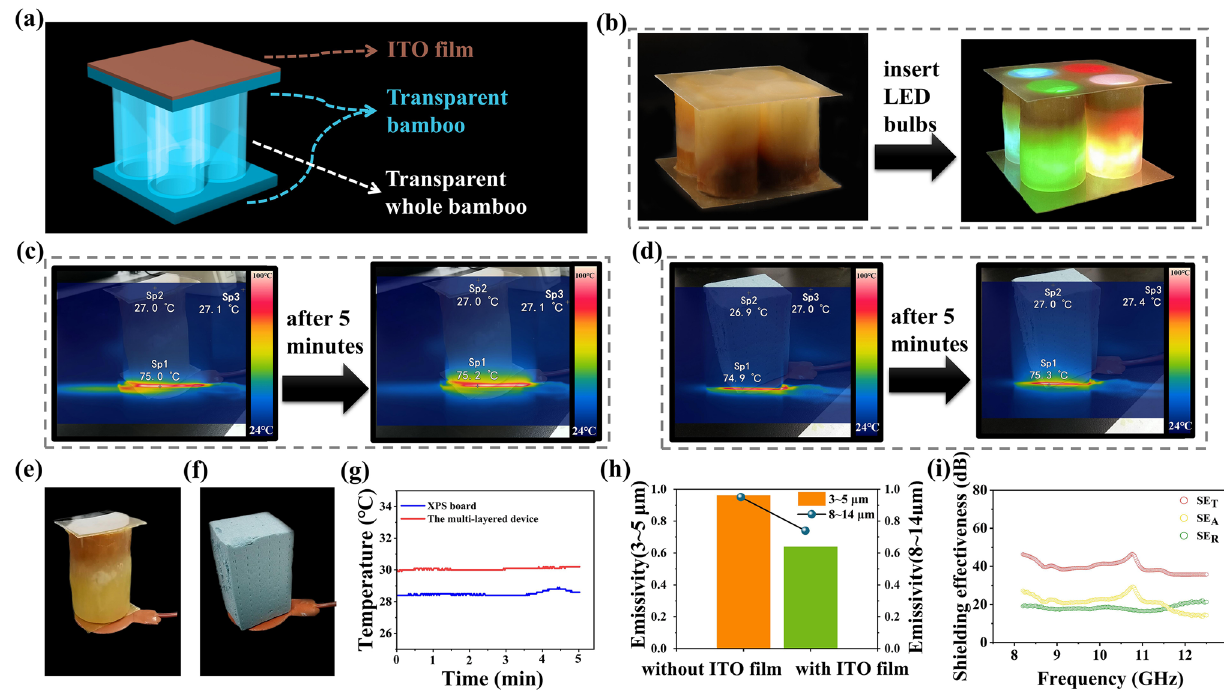
Fig. 6 a Schematic diagram of the multilayered device composed of translucent whole bamboo, transparent bamboo, and ITO film. b Compari- son before and after installing LED light bulbs in the multilayered device. c Infrared thermal image of the multilayered device before and after heating. d Infrared thermal image of XPS insulation board before and after heating. e Photograph of the multilayered device on the heating plat- form. f Photograph of the XPS insulation board on the heating platform. g Temperature variation diagram of the multilayered device and XPS insulation board on the heating pad. h Infrared emissivity at 3 ~ 5 μm and 8 ~ 14 μm of the multilayered device. i Shielding effectiveness of the multilayered